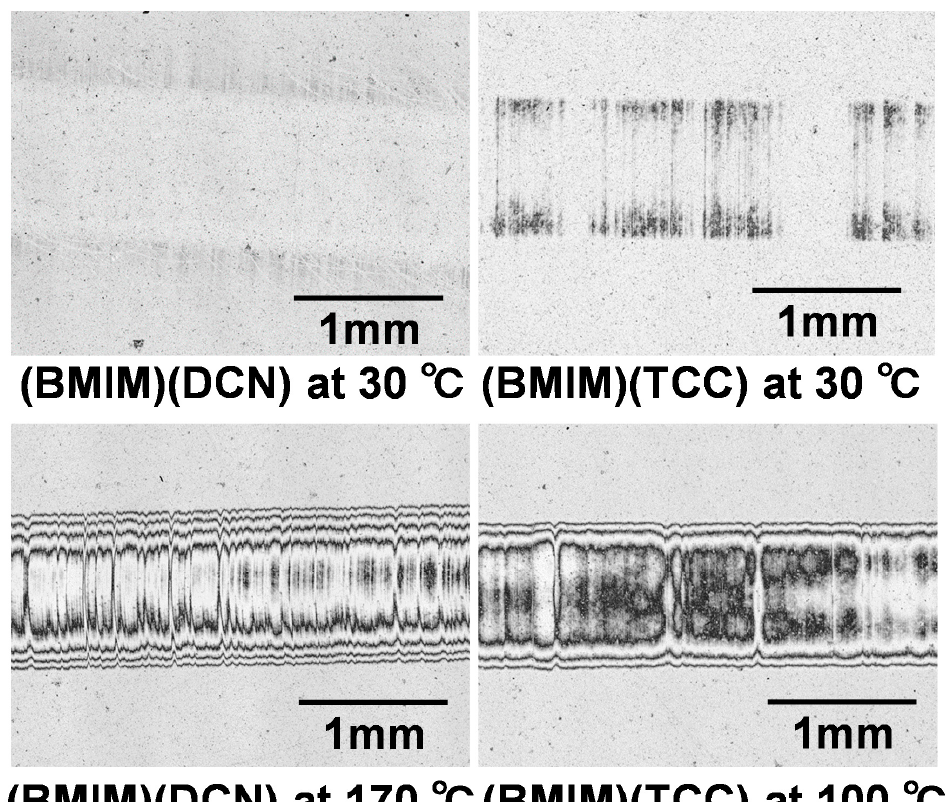
Figure 3. Images of the worn surfaces of ta-C films subjected to friction under different conditions.